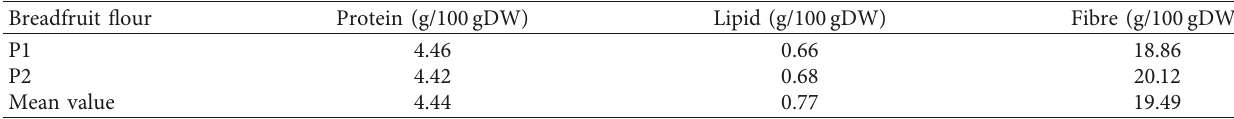
Table 6: Macronutrient content of dried breadfruit flour samples.